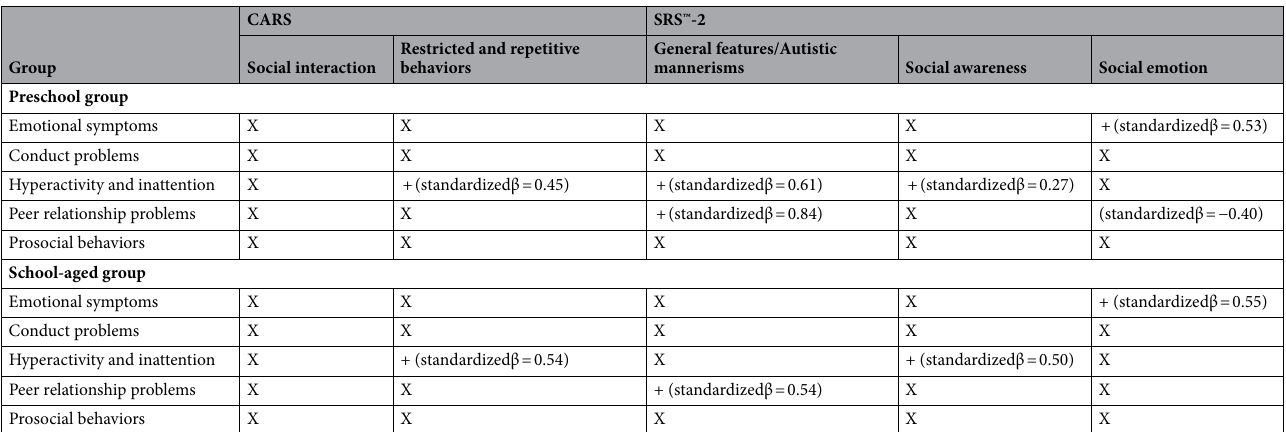
Table 4. Summary of the predictions of symptoms of autism on the emotional and behavioral problems. (N =108). X: no significant relationship, +: positive significant relationship, −: negative significant